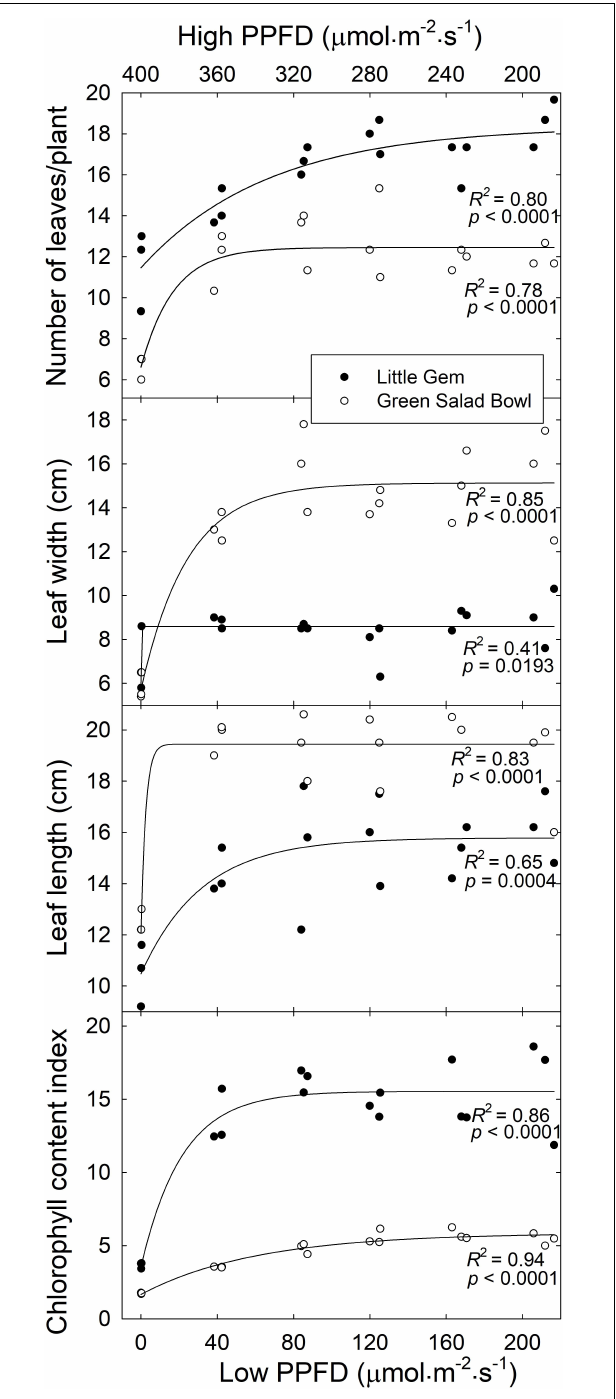
FIGURE 2 | Number of leaves per plant, leaf width, leaf length, and chlorophyll content index as a function of treatment ( x -axis indicates lower PPFD ). Symbols (three replications per treatment) represent cultivars ‘Green Salad Bowl’ (open symbols) and ‘Little Gem’ (closed symbols) of lettuce ( Lactuca sativa ). Measurements are from the three center plants from each tray. Plants were grown under fluctuating photosynthetic photon flux density ( PPFD ), with PPFD changing every 15 min between high and low intensities ( ∼ 400/0, 360/40, 320/80, 280/120, 240/160, and 200/200 µ mol · m − 2 · s − 1 ).